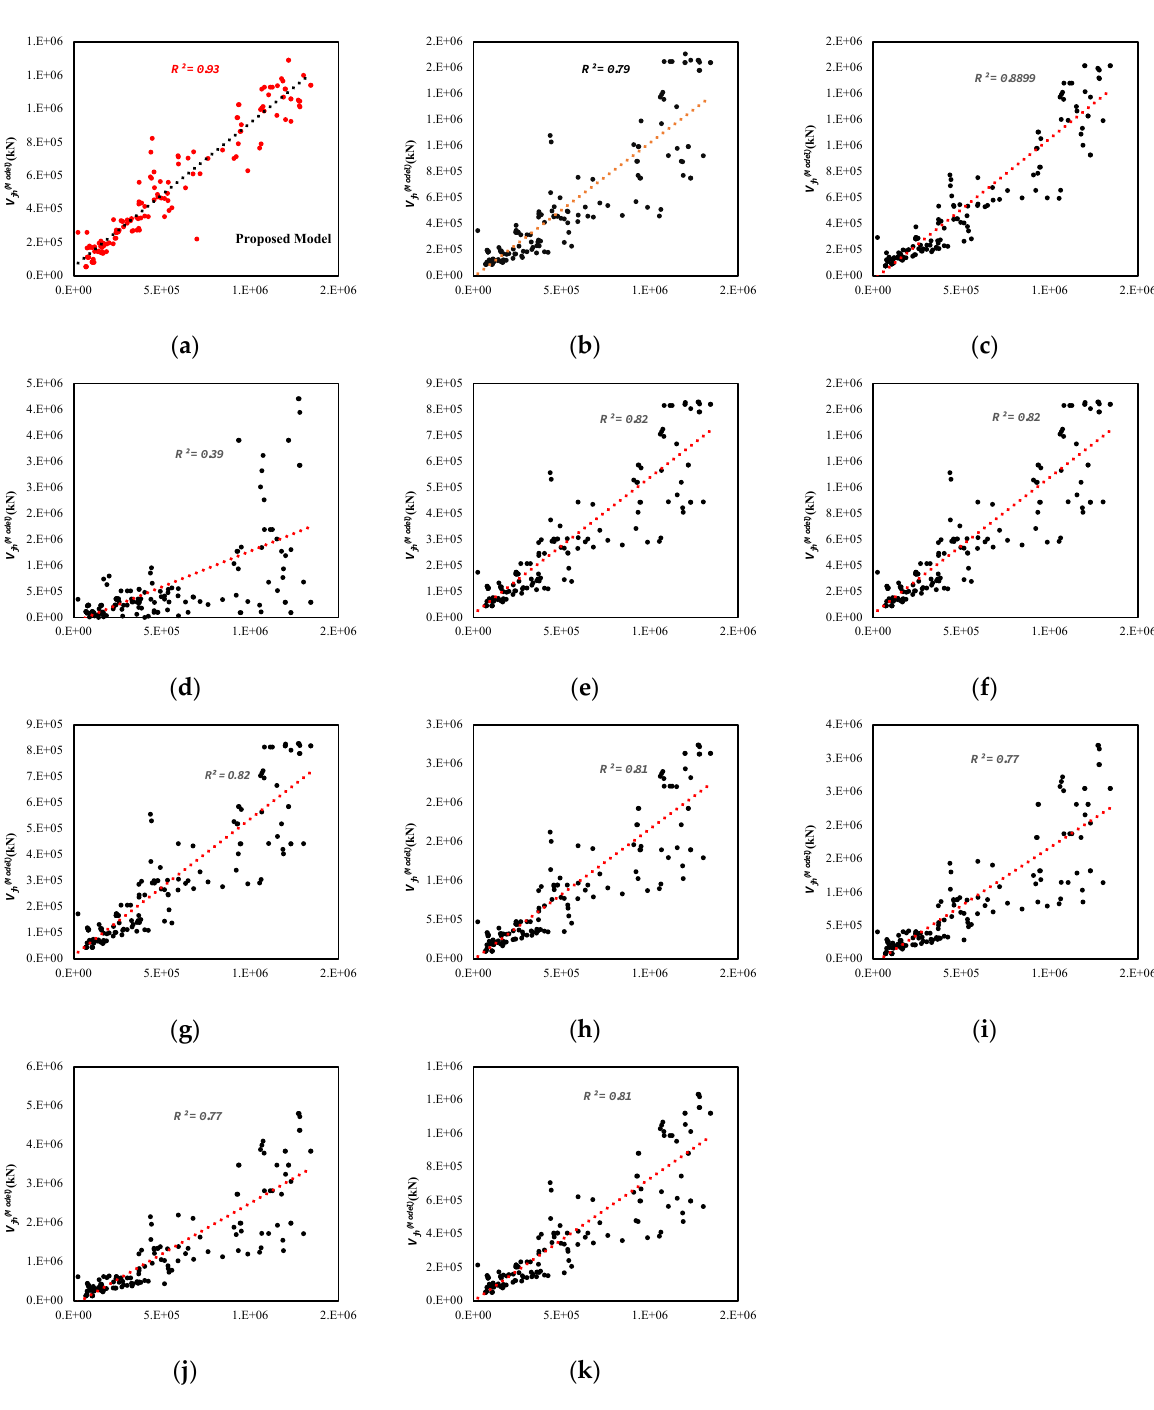
Figure 10. Comparison of the reinforced RC exterior joint: ( a ) Proposed Equation, ( b ) Vollum et al. [24] ( c ) Bakir et al. [4] ( d ) Montenious et al. [27] ( e ) Kim et al. [28], ( f ) ACI 352R-02 [22] ( g ) ASCE 41-17 [23] ( h ) Eurocode [18] ( i ) New Zealand code [17] ( j ) Chinese code [19] ( k ) Japanese code [20].